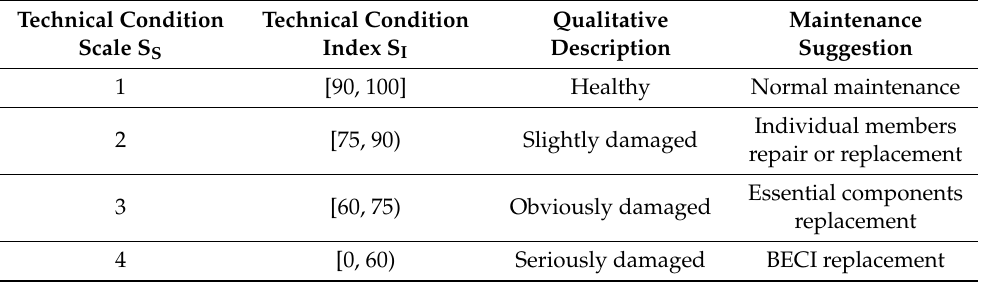
Table 11. Technical condition scale classification.